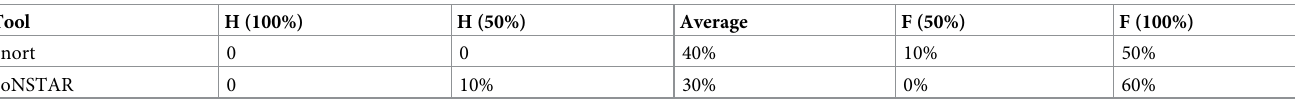
Table 9. Horrible to fantastic evaluation.